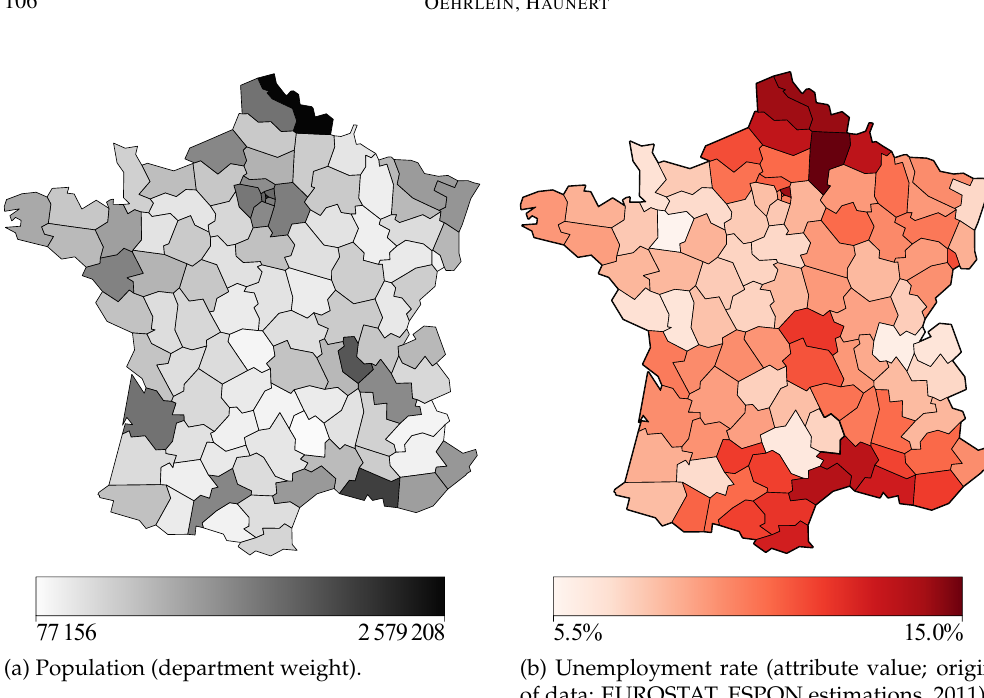
Figure 8: input data for statistical aggregation of France’s